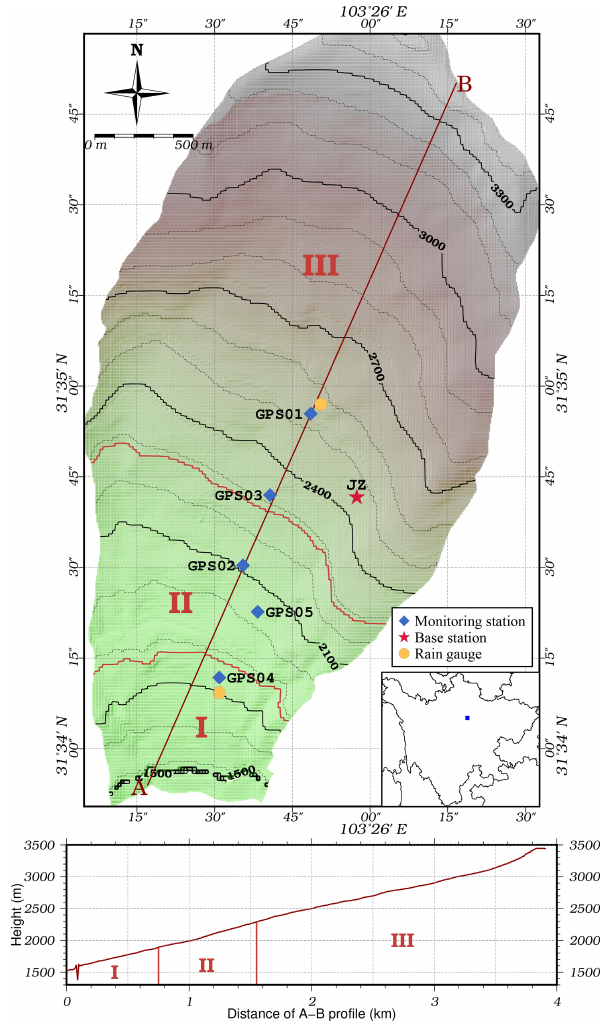
Figure 3. The distribution of the three parts (I–III), GPS stations and rain gauges at the Xishan landslide.